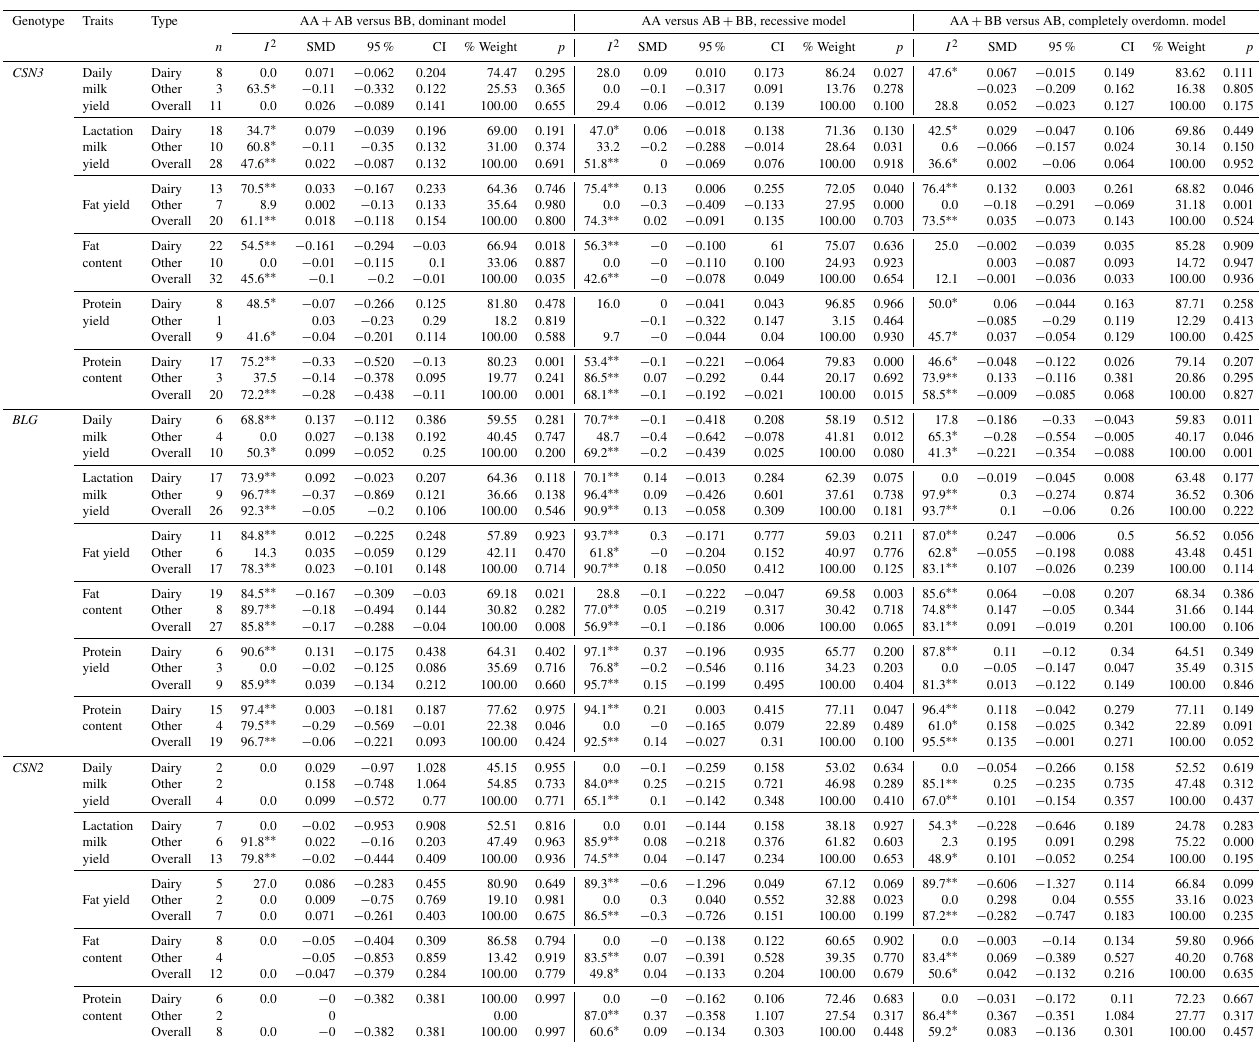
Table 1. Genetic model analyses of the genotypes related to BLG, CSN2 , and CSN3 . Genotype